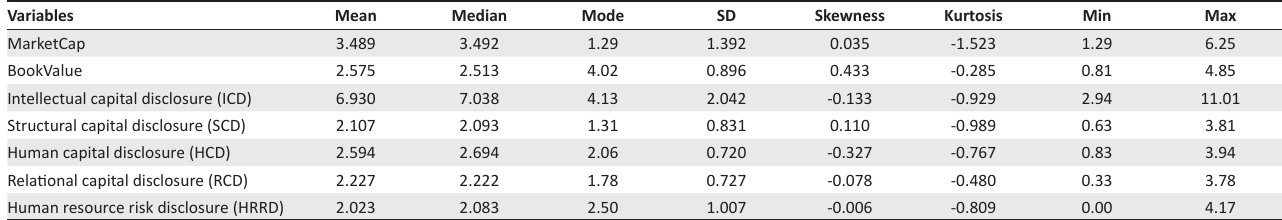
TABLE 2: Descriptive statistics. Variables